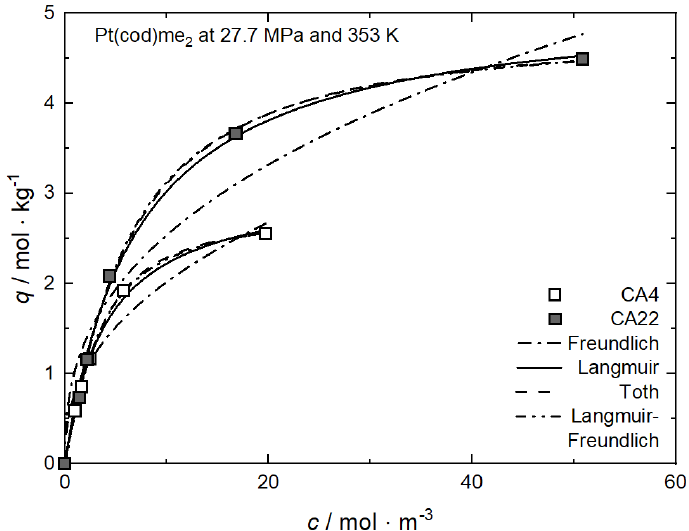
Figure 6. Uptake of Pt(cod)me 2 at 27.7 MPa and 353 K on different substrates; experimental data taken from [37].